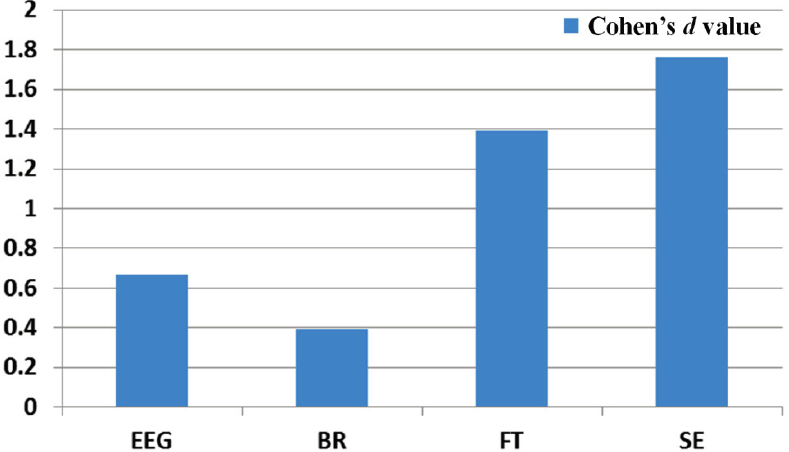
Figure 13. Calculated Cohen’s d values of each measurement.